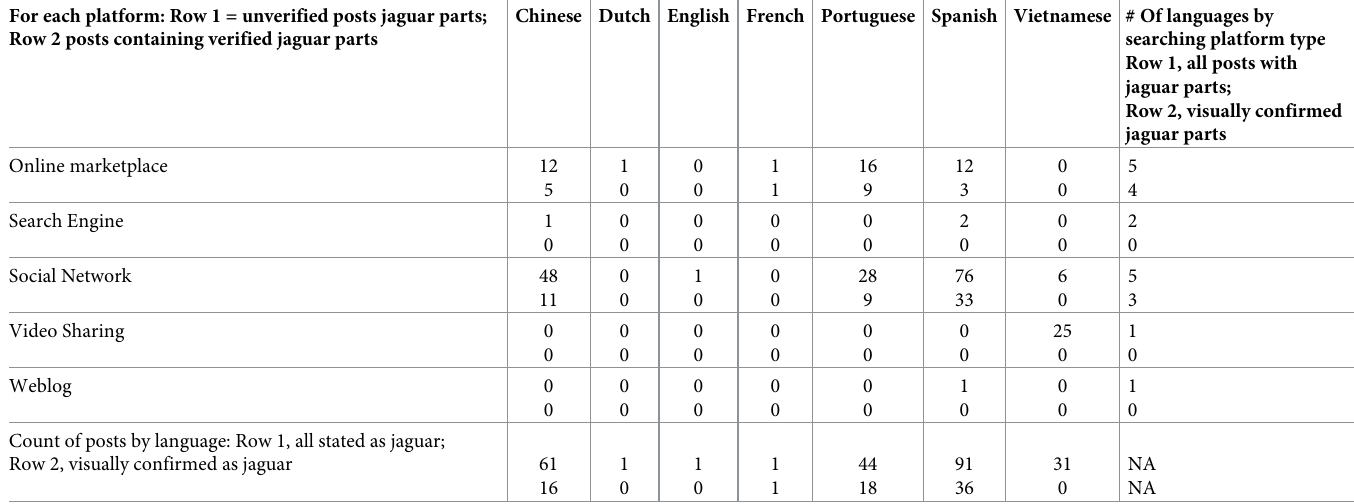
Chinese Dutch English French Portuguese Spanish Vietnamese # Of languages by